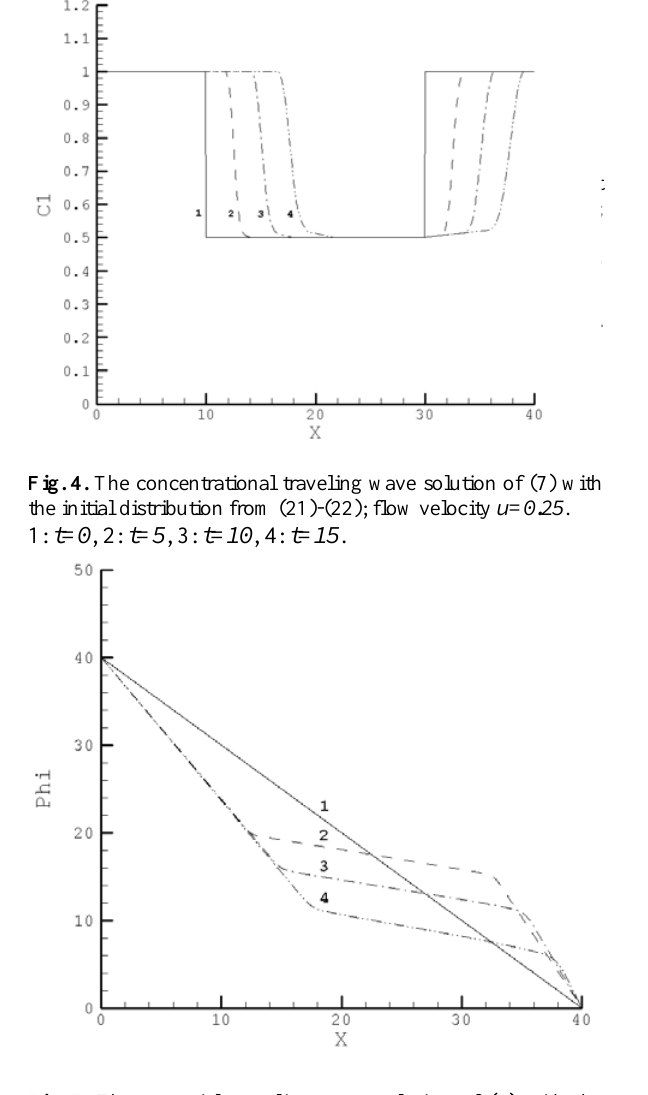
Fig. 3. Unstable branch A of the curve η=η(k) for different flow velocities: 1: u=0.0 ; 2: u=0.1 ; 3: u=0.25 ; 4: u=0.50 ; 5: u=0.75 ; 6: u=1.0 .